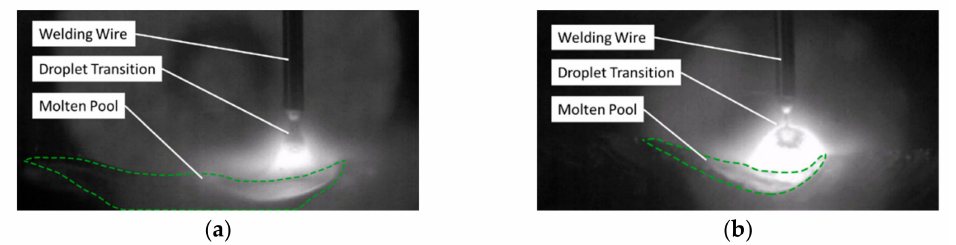
Figure 4. Highspeed images during buildup of Al-4047 ( a ) and Al-5356 ( b ).